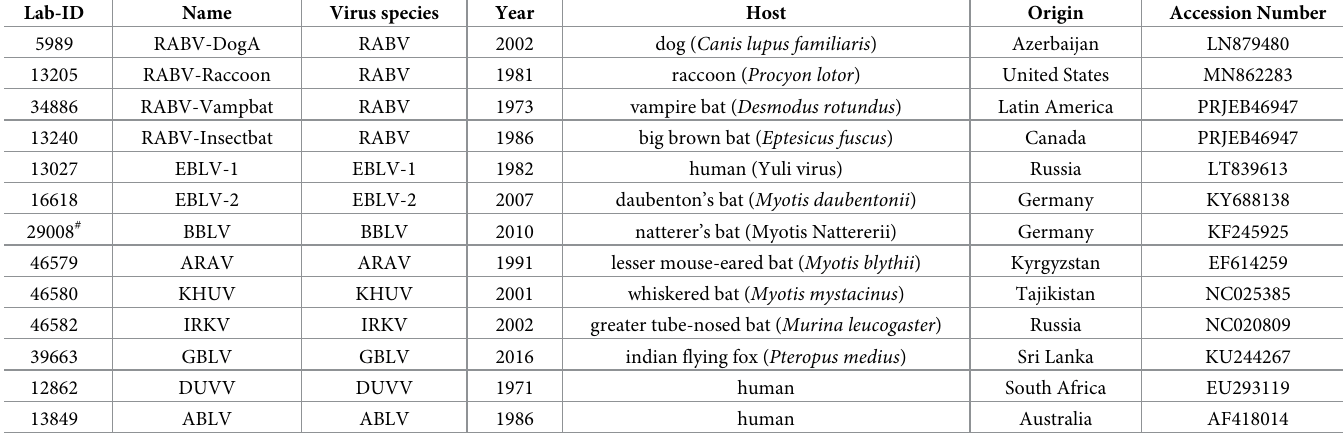
Table 1. Viruses used in the study, including details of their year of isolation, the respective host, and origin.